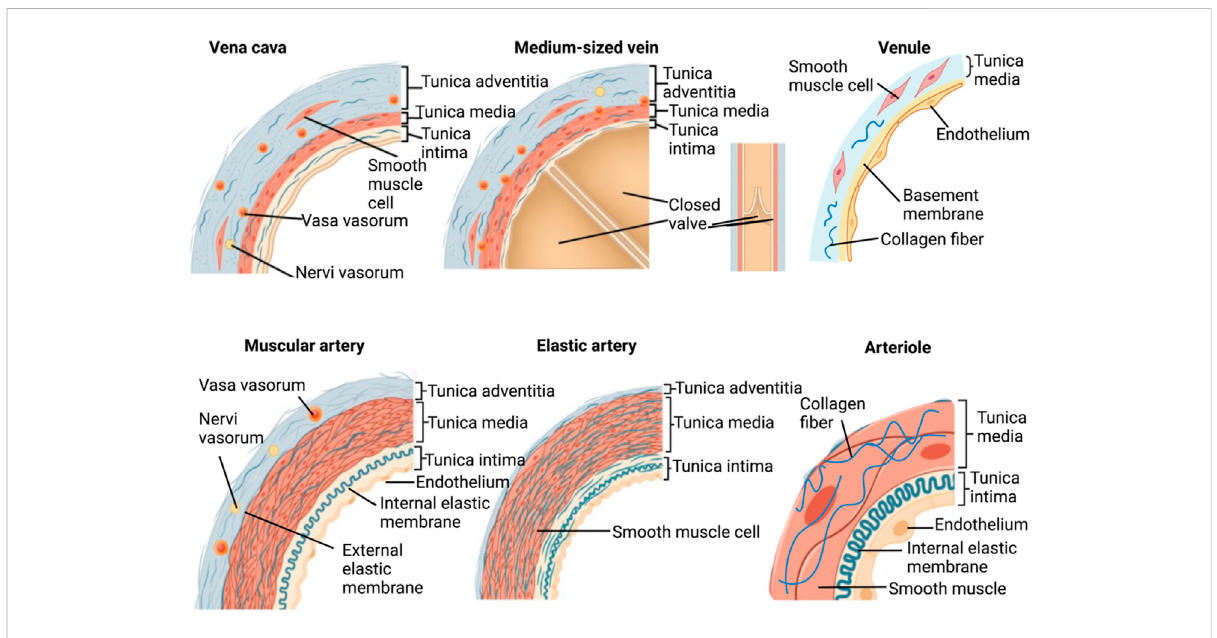
FIGURE 1 Structures of major native small- to large-caliber blood